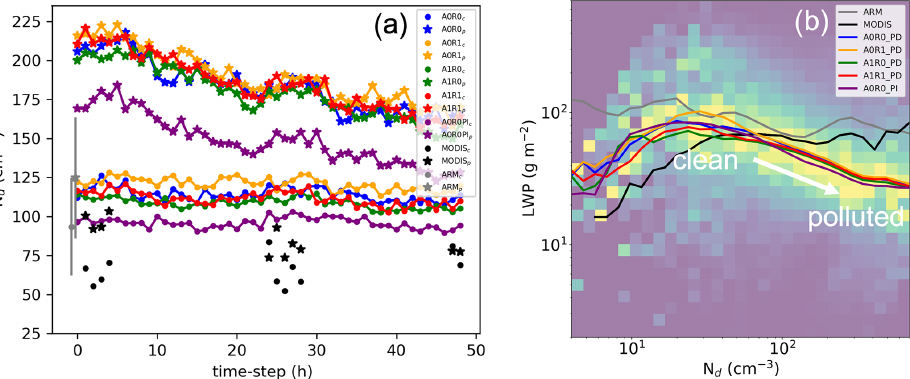
Figure 10. (a) Cloud droplet concentration for clean (circle) and polluted (asterisks) air masses averaged along forward trajectories from each E3SM experiment. (b) Joint histogram of the liquid water path (LWP) and cloud droplet number concentration for E3SM. Median LWP is plotted over the joint histogram for each observational and simulation-based data